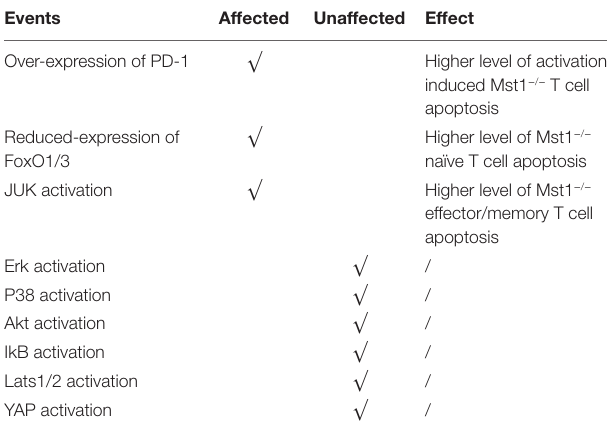
TABLe 1 | The events affected and unaffected in Mst1 − / − T cell